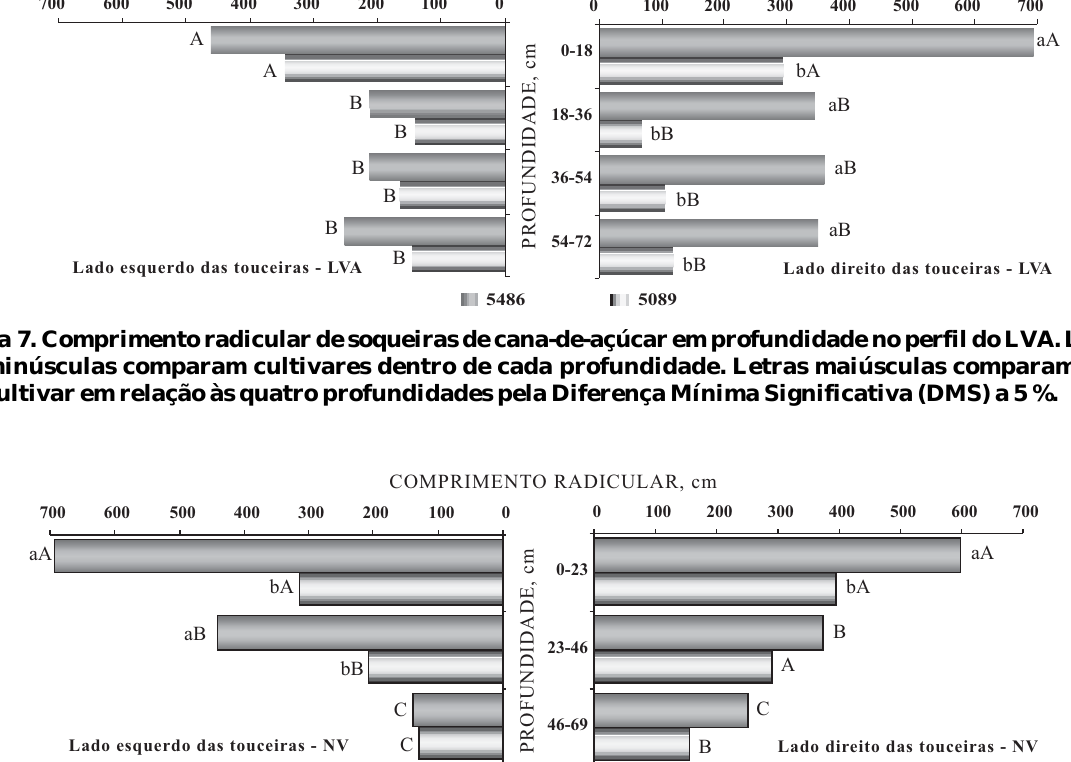
Lado esquerdo das touceiras - NV